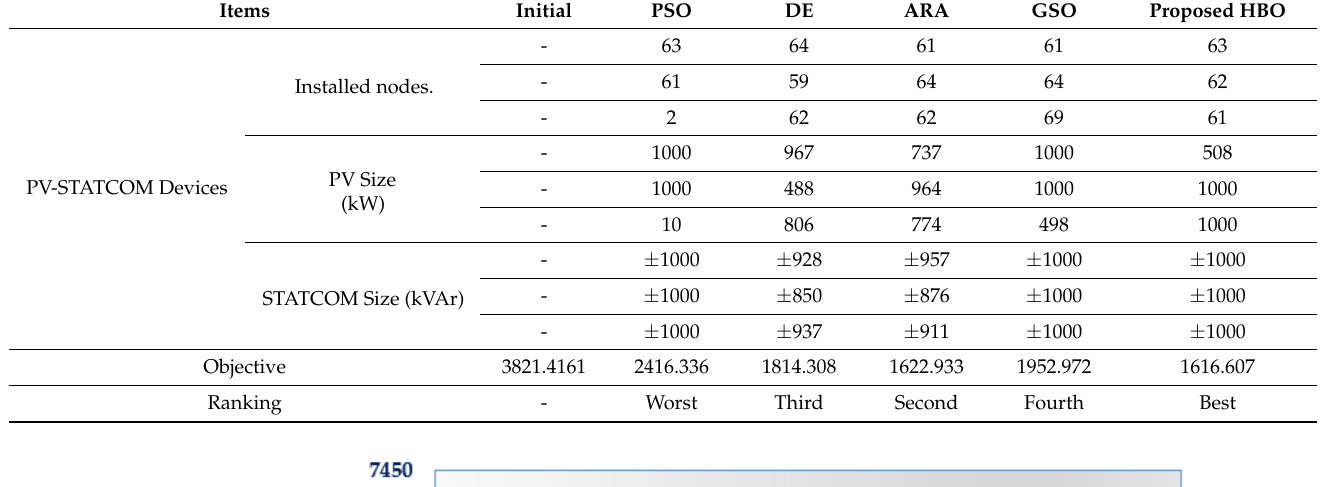
Table 3. PV-STATCOM allocations for IEEE 69-distribution feeder.